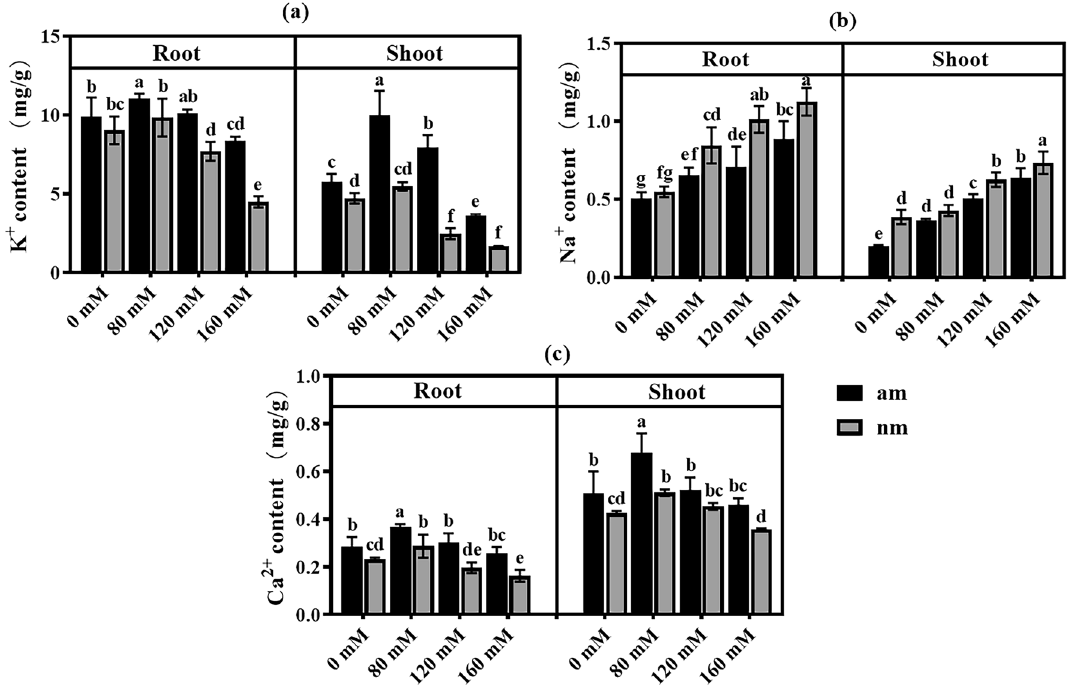
Fig. 5 Aboveground and root ion contents of rice at different salt concentrations. Note: a K + content; b Na + content; c Ca. 2 + content; the result is the mean standard deviation of three repeats. Different letters represent the differences between different treatment groups. ( P < 0.05) ±